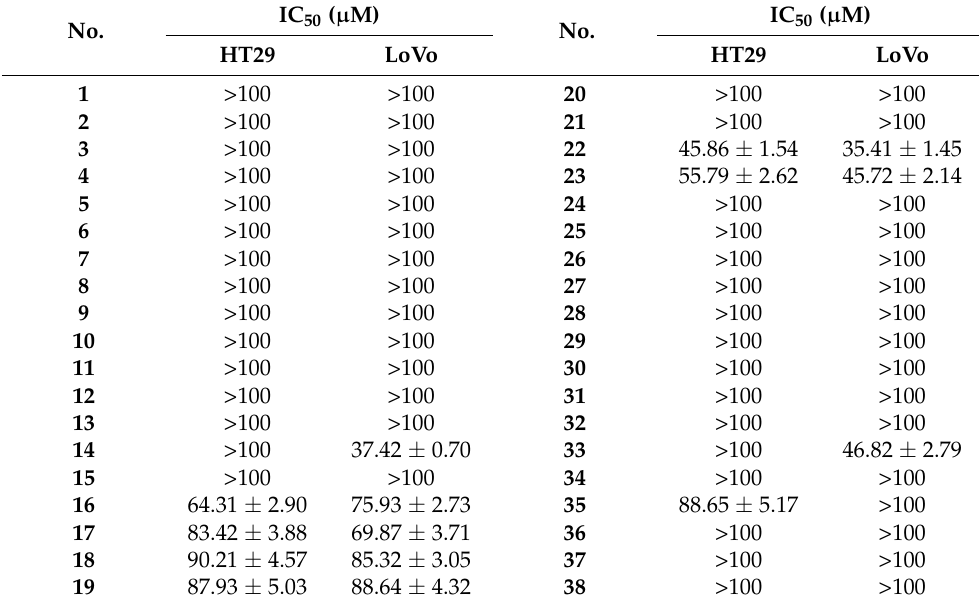
Values were means ± SEM of three